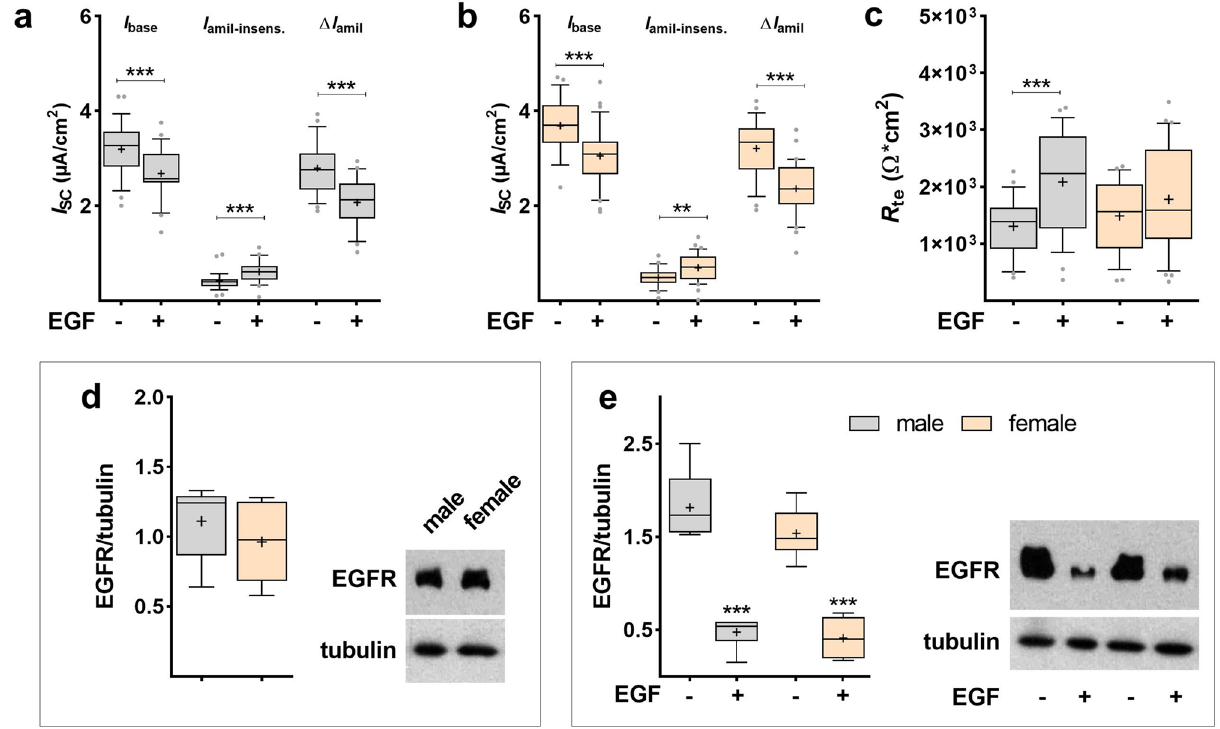
Figure 8. EGF decreased Na + transport in epithelial-fibroblast co-cultures of both sexes. FDLE cells were co-cultured with fetal lung fibroblasts in SF-Med and stimulated with EGF for 24 h. Data are displayed as box and whiskers with the 10–90 percentile, mean (+) and median (horizontal line). In male ( a ) and female ( b ) FDLE cells, EGF significantly decreased I base and Δ I amil and increased I amil-insens (n = 26–32; ** p < 0.01; *** p < 0.001 by t -test). ( c ) EGF significantly increased R te only in male cells (*** p < 0.001). ( d ) EGFR protein expression was not different between male and female fetal lung fibroblasts cultured in serum-supplemented medium (n = 6). ( e ) EGF application to fetal lung fibroblasts cultured in SF-Med strongly decreased EGFR protein levels after 24 h in both, male and female fibroblasts (n = 4; *** p < 0.001 by t -test). (Grey boxes) male; (yellow boxes) female.